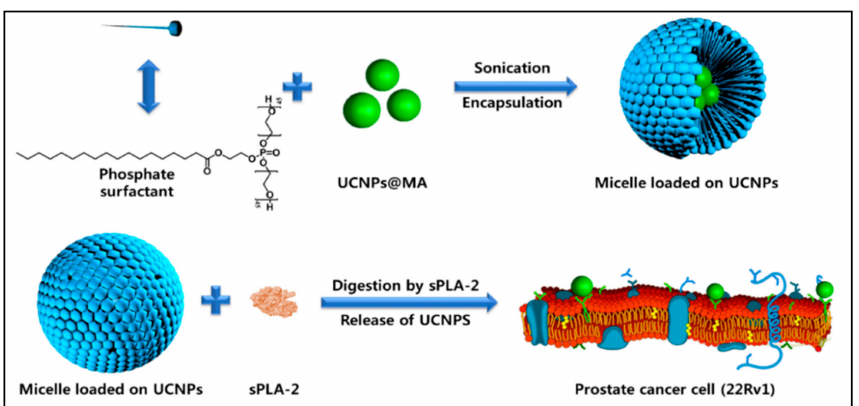
Figure 16. Preparation of phosphate micelle coated UCNPs and the UCNPs release mechanism under sPLA-2 enzyme trigger. Reprinted with permission from [21]. Copyright © 2017, Springer